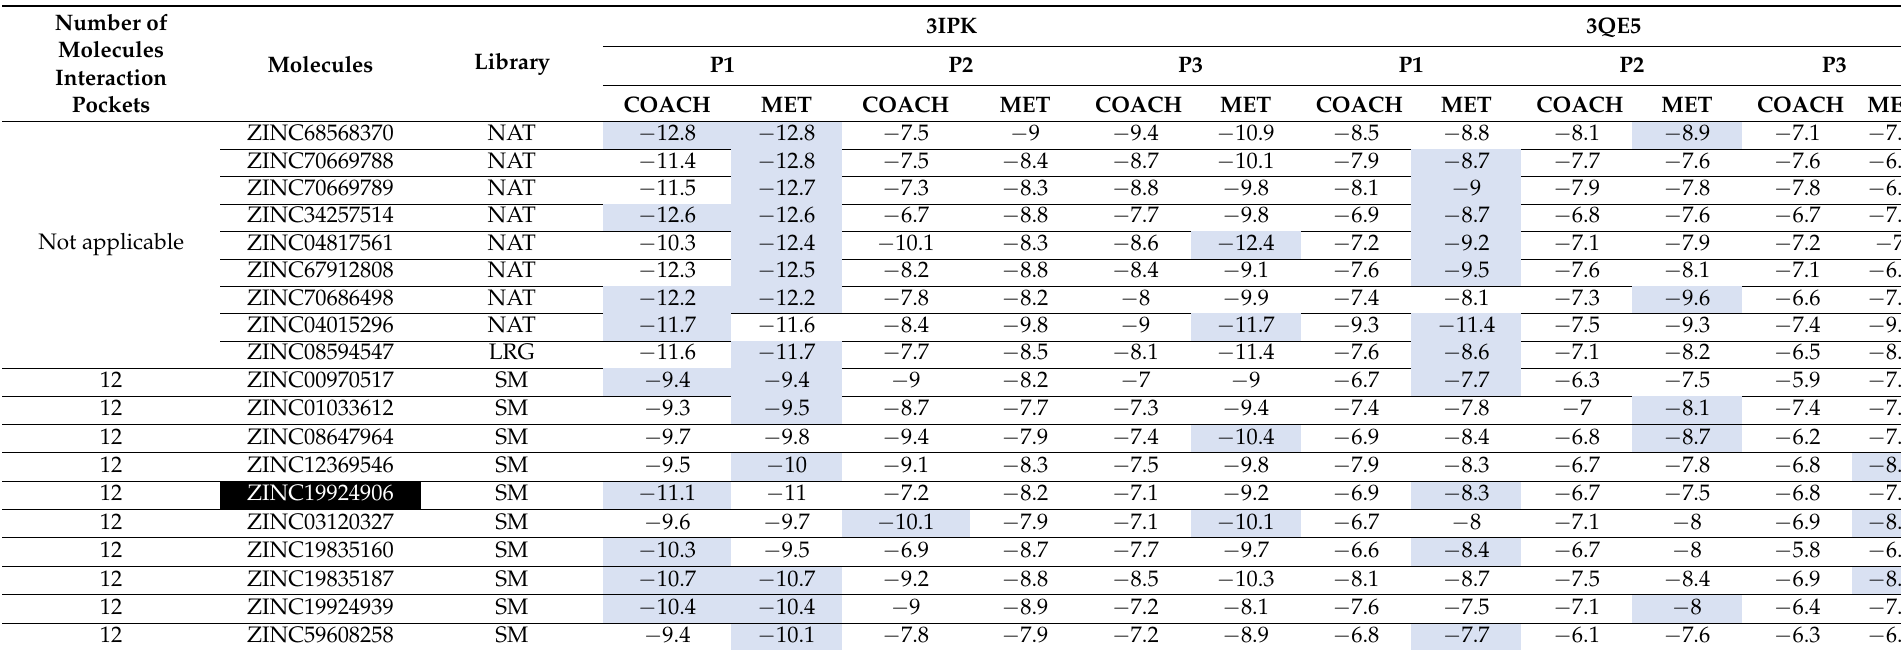
Table 1. Energy interaction data obtained from recoupling using Autodock Vina with an exhaustiveness of twenty for the 3IPK and 3QE5 proteins with the selected molecules, molecule libraries and number of pockets in which each molecule interacted. The molecule highlighted in black was the only one that interacted with high affinity in different sites in both 3IPK and 3QE5 proteins. COA: COACH program. MET: Metapocket 2.0 program. Values highlighted in light blue represent the lowest interaction energy